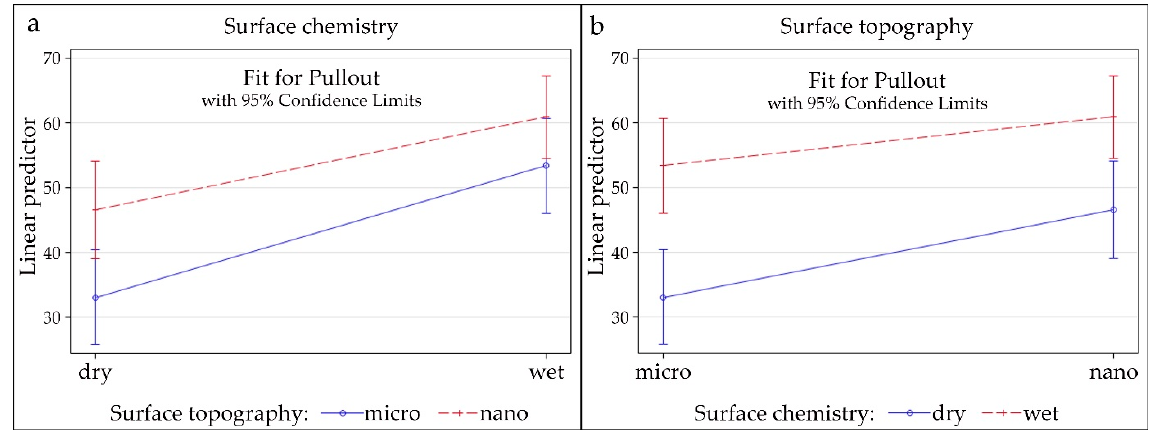
Figure 4. ( a ) Simple effects of surface chemistry; ( b ) Simple effects of surface